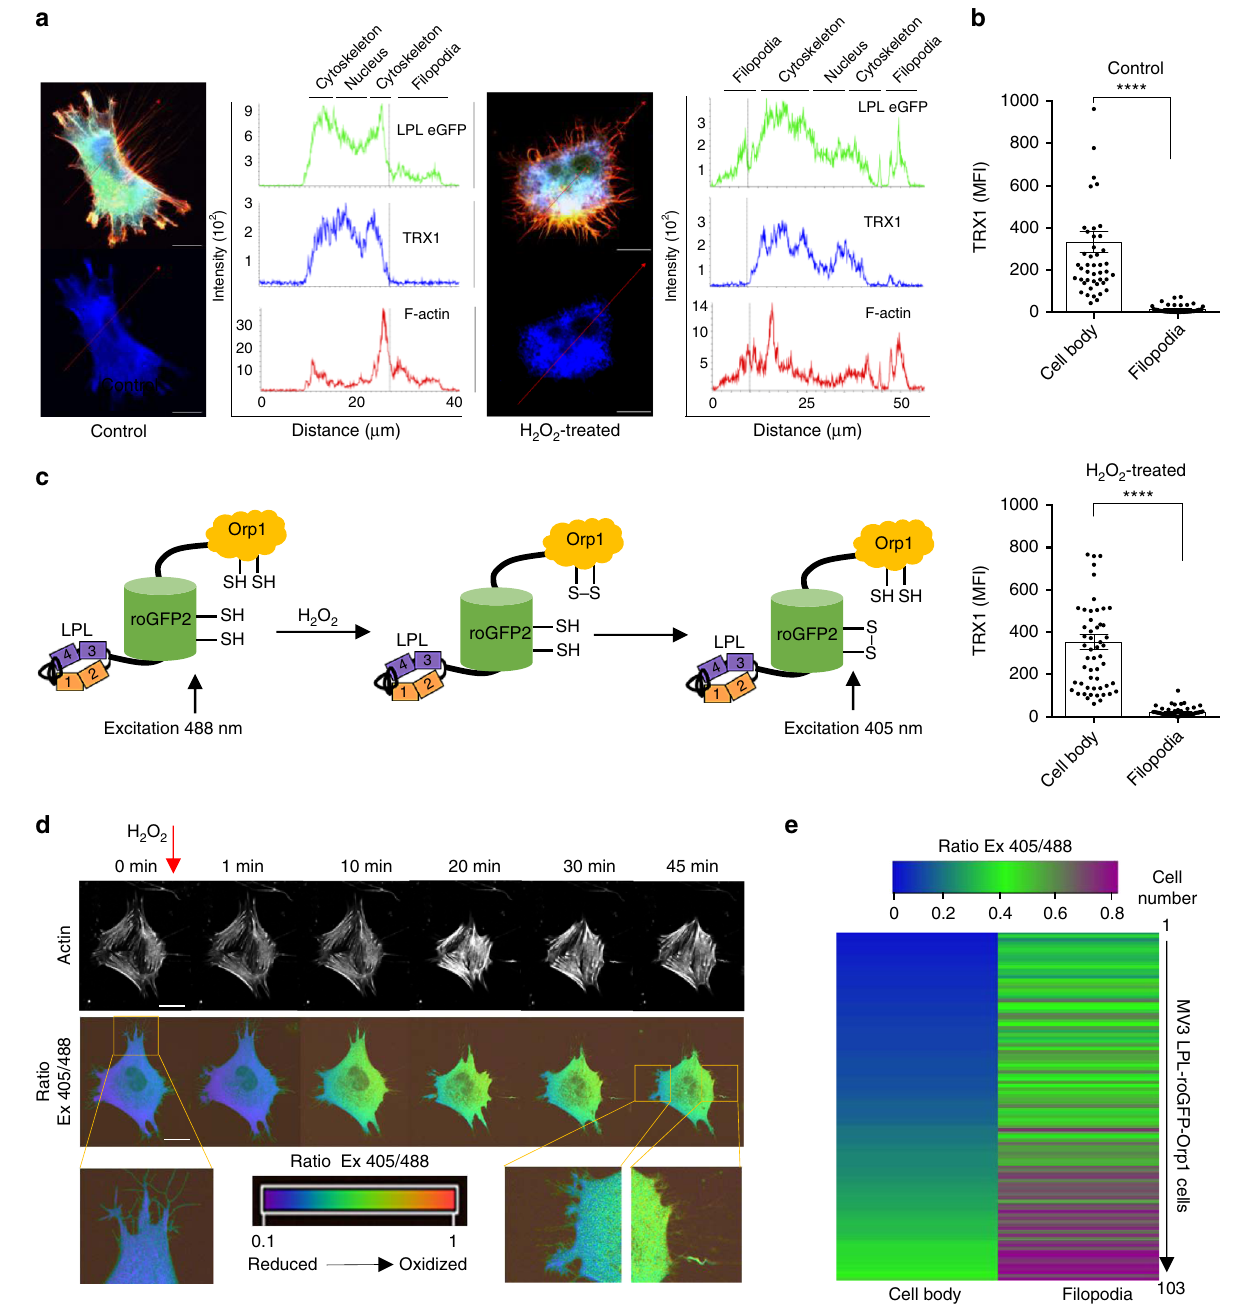
Fig. 5 LPL-roGFP-Orp1 is spatially oxidized at protrusions of cells. a Intensity pro fi les of TRX1, LPL, and F-actin in untreated (left) and 50 μ M H 2 O 2 -treated (right) MV3 wt LPL eGFP cells. MV3 LPL eGFP cells (green) that fi rmly adhered to poly-D-lysine-coated coverslips overnight were kept untreated or were treated with 50 μ M H 2 O 2 for 30 min. The samples were then fi xed and stained for TRX1 (blue) and F-actin (red). The samples were imaged using a confocal microscope ( n = 5). Scale bar = 10 µ m; ×100 magni fi cation. b Quanti fi cation of TRX1 in fi lopodia and cell bodies. At least 50 cells were analyzed from three independent experiments. The data are presented as the mean ± SEM ( n ≥ 3; **** p < 0.0001, ns nonsigni fi cant). P -values were calculated by t - test. c Schematic diagram of the LPL-roGFP-Orp1 sensor. d Representative time-lapse images of MV3 LPL-roGFP-Orp1 cells. The upper panel shows F-actin (white), and the lower panel shows the oxidation state of the roGFP-Orp1 probe. The magni fi ed area shows fi lopodial extensions. The color scale from dark blue to green and red indicates the oxidation state of the sensor. Ratio imaging was performed with a confocal microscope equipped with dual excitation features ( n ≥ 3). Scale bar = 10 µ m; ×100 magni fi cation. e Heat map showing the ratio of oxidized (excitation (Ex) 405 nm) to reduced (Ex 488 nm) roGFP- Orp1 in LPL-roGFP-Orp1-expressing cells in the absence of H 2 O 2 (time-lapse imaging, t = 0 h, three independent experiments, n = 103 cells). Each lane represents a single cell. The color scale from blue to green and magenta indicates the oxidation state of the sensor in different